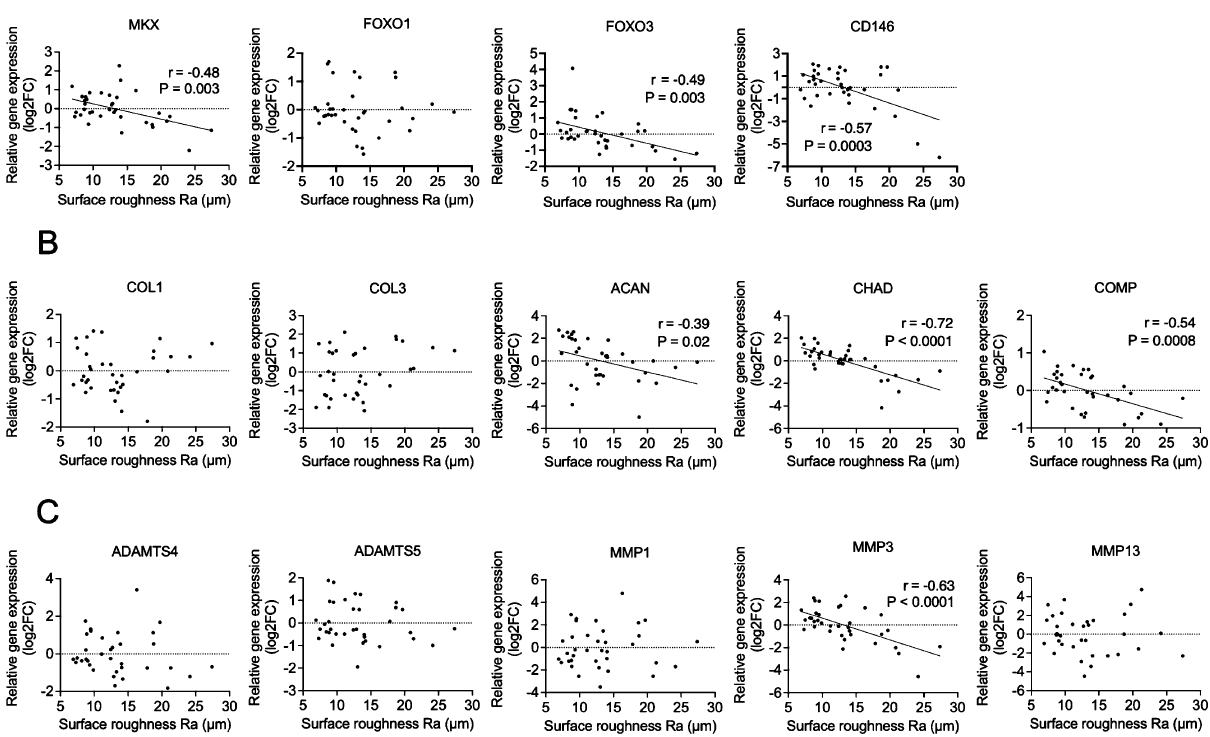
Figure 3. Correlation of surface roughness with gene expression in the meniscus. A total of 36 samples from six menisci were included in each study. ( A ) Correlation with meniscus degeneration-related gene expression. ( B ) Correlation with meniscus matrix gene expression. ( C ) Correlation with matrix degradative enzyme gene